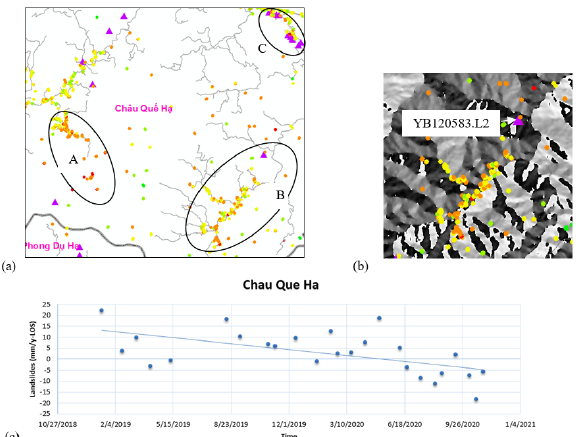
Figure 7 . (a) Distribution of permanent scatter points showing landslide rate, (b) the positions of PS points matched with survey point in Chau Que Ha commune are superimposed on aspect map, (c) the chart of landslide point selected from (b).